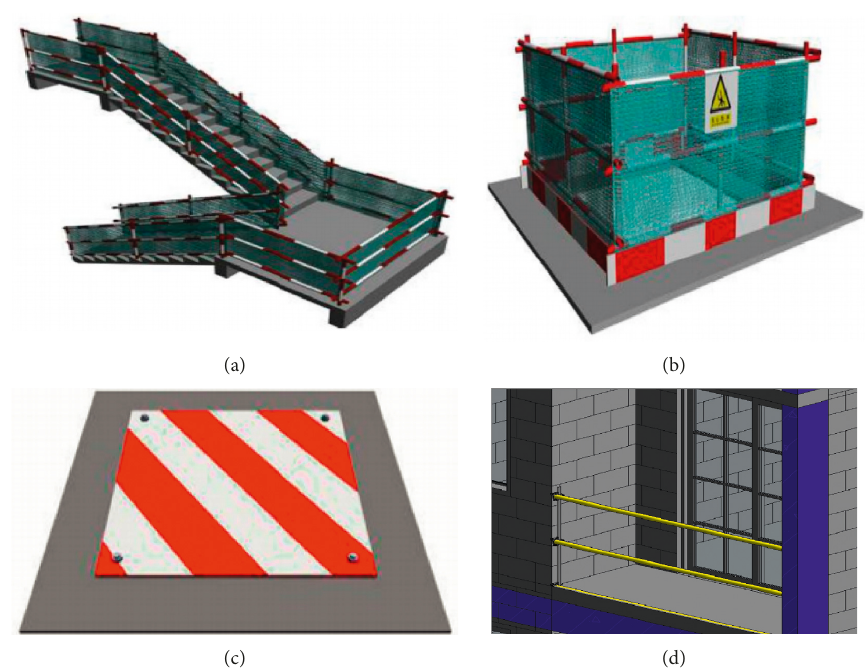
Figure 7: Protection measures for the edge and the